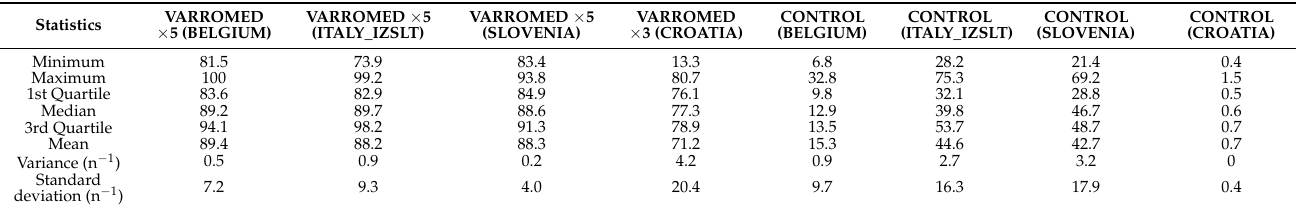
Table 2. Acaricide efficacy recorded during the summer/autumn trial in the apiaries and relative mite fall during the same period in the control group